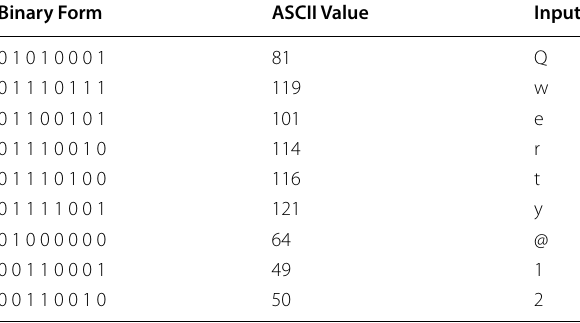
Text After Decryption- Qwerty@123